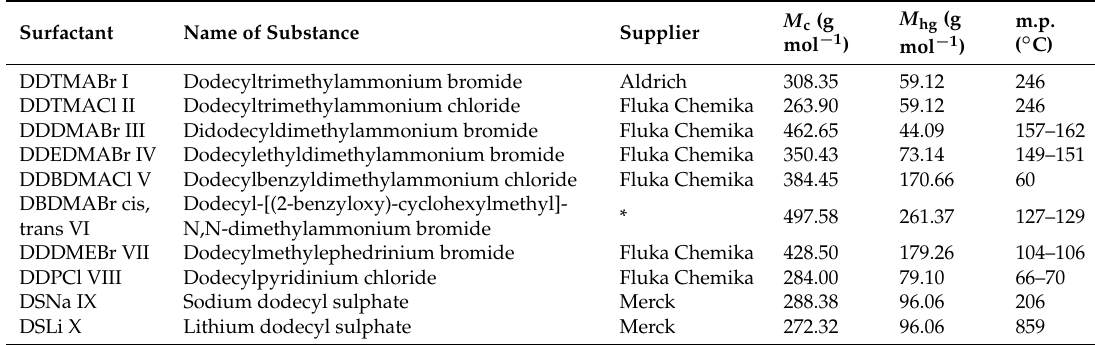
Table 1. Fundamental characteristic of studied